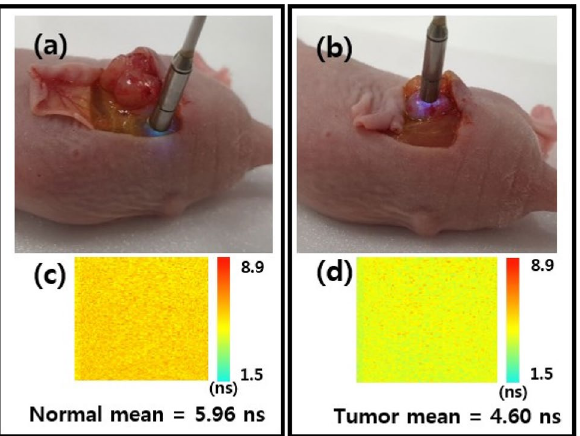
Figure 3. Demonstration of fluorescence lifetime distinction between tumor and normal tissues in mice. ( a , b ) The top row shows the fluorescence lifetime measurement images for normal and tumor tissues using the proposed system in mice with subcutaneous MDA-MB-361 breast tumors. ( c , d ) Fluorescence lifetime images over 100 by 100 pixels and its mean value in normal tissue of ( a ) and in tumor tissue of ( b ). The color bar represents the fluorescence lifetime in